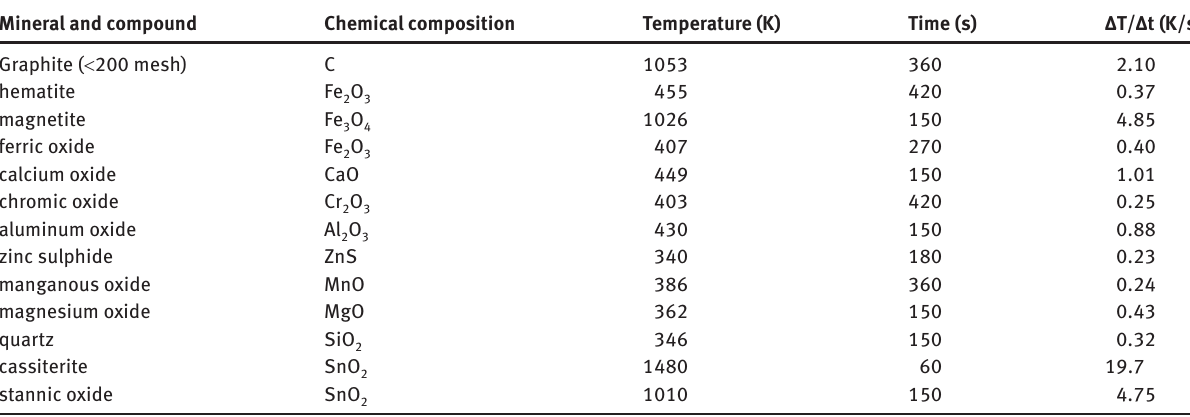
Table 5: Heating effect of MW of minerals and compound [19] Mineral and